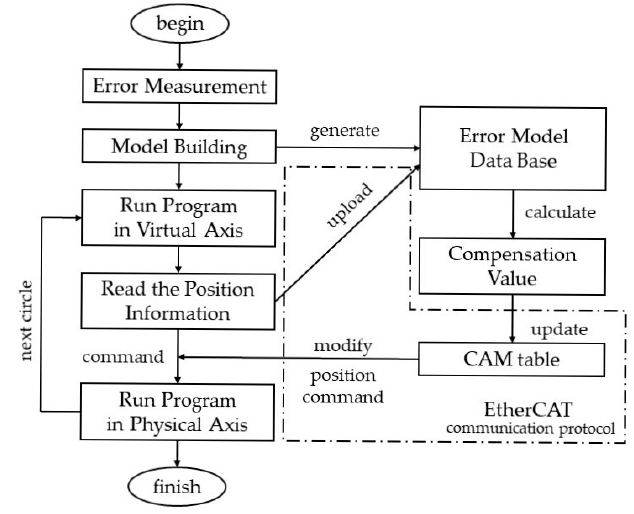
Figure 10. The process of the proposed compensation method.